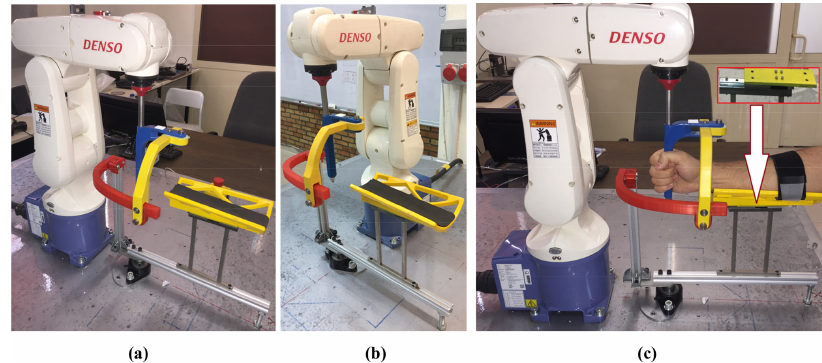
Figure 13. Overall system with base for forearm.